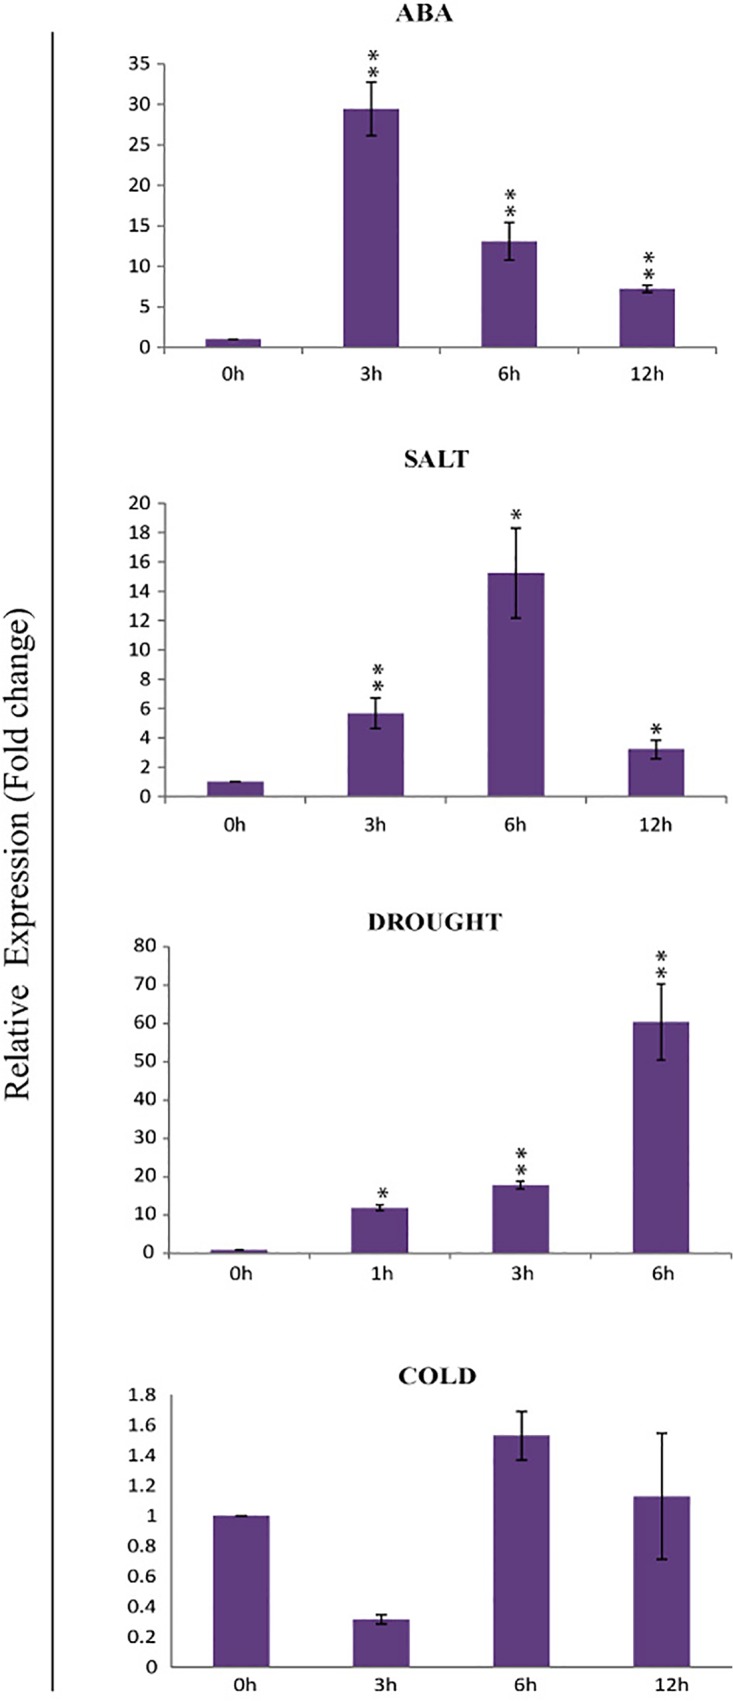
Expression profile of OsPP108 under ABA and abiotic stresses.qPCR analysis was performed to generate the expression profile of OsPP108 under ABA, salt, drought and cold treatment in rice seedlings. Different time period of treatment in hours is indicated on X-axis and fold change in expression level w.r.t. untreated control sample is indicated on Y-axis. Each bar represents mean value of two replicates. Standard error among the samples is indicated by error bars. * represents p-value < 0.05 and ** p-value < 0.01 for treated samples w.r.t. untreated control (0h).